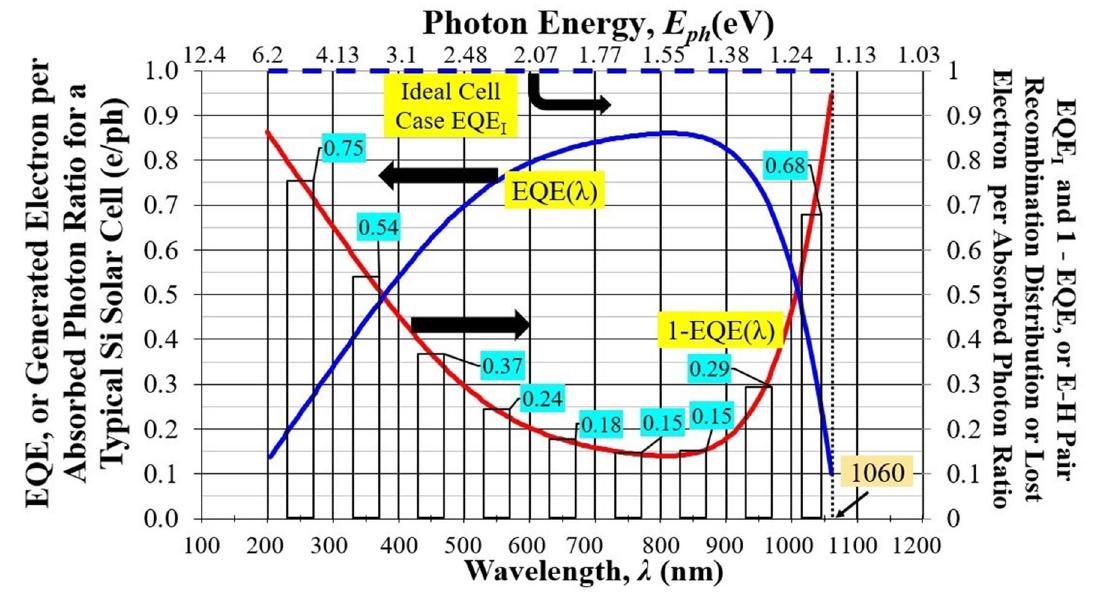
Fig. 2 EQE and carrier recombination loss distribution